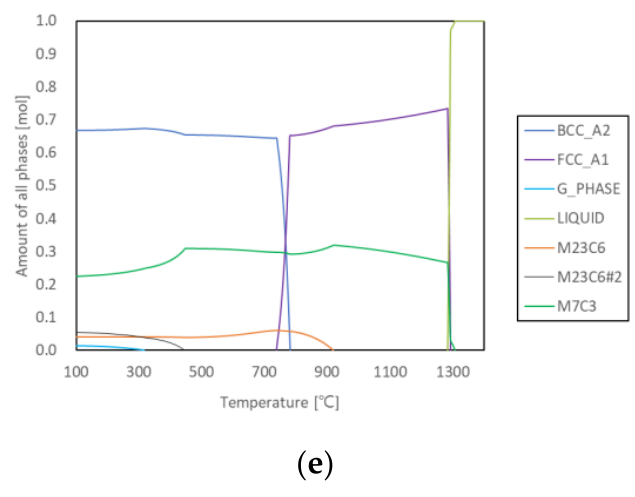
Figure 1. ThermoCalc calculation of the alloys [5]: ( a ) 2124; ( b ) 2127; ( c ) 2427; ( d ) 2827; ( e ) 2927.